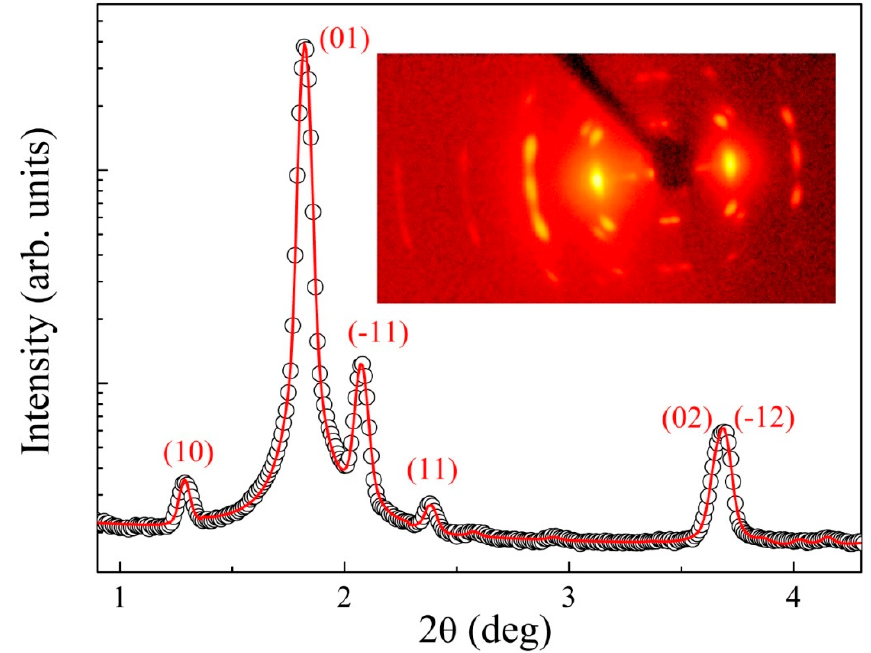
Figure 7. X-ray diffraction (XRD) intensity profile in the small-angle region for LJ10/10 at temperature T = 110 °C. In the inset, the 2D pattern is shown for a partially oriented sample at the same temperature.